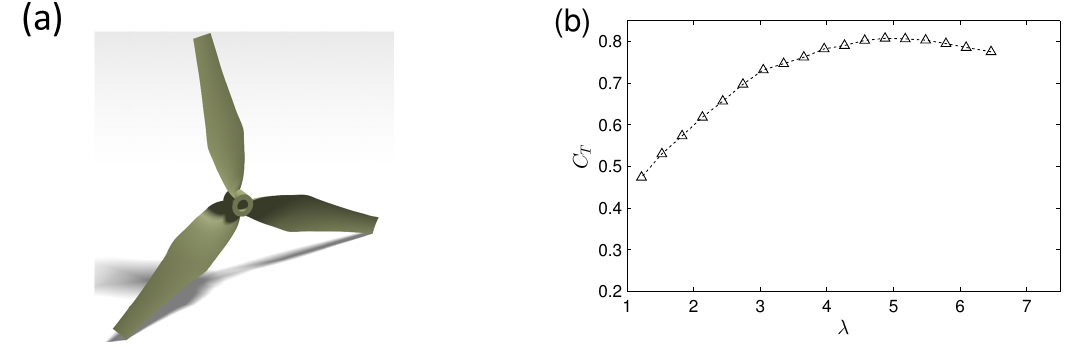
Figure 4. ( a ) Sketch of the new designed turbine rotor; ( b ) Variation of the thrust coefficient C T of the miniature turbine with the tip-speed ratio λ at ¯ u = 5